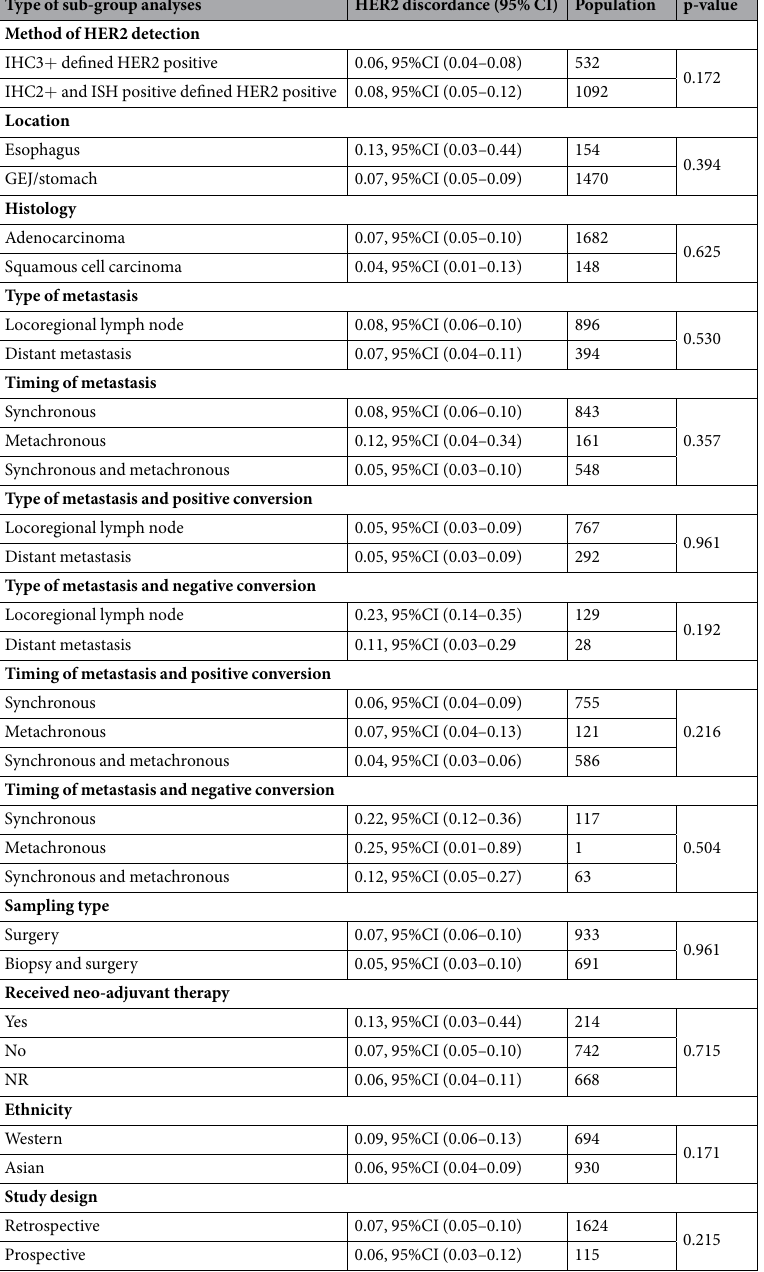
Table 4. Random-effect single arm subgroup analyses of proportions of HER2 status